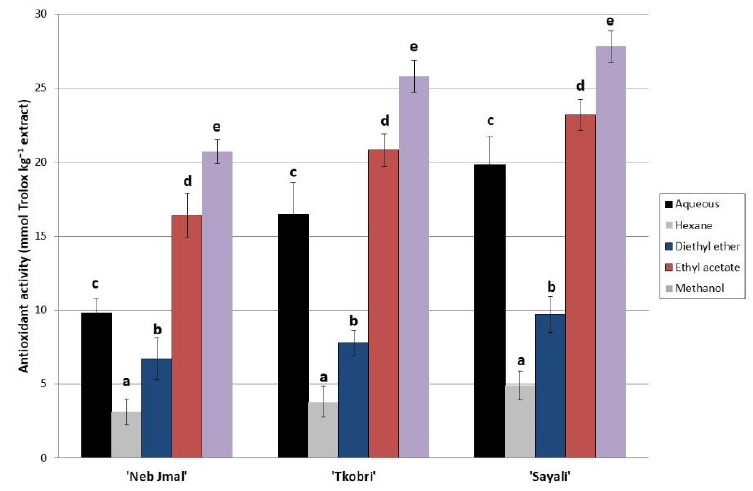
Figure 1. Antioxidant activity of OLE from ‘Sayeli’, ‘Tkobri’, and ‘Neb Jmel’ varieties extracted with different organic and aqueous solvents. Lowercase letters ( a – e ) mean statistically significant differences between different solvents used for each variety (Tukey’s HSD test, p < 0.05). Table 2. Polyphenols concentration of aqueous OLE (mg 100 g − 1 ) after in vitro gastrointestinal